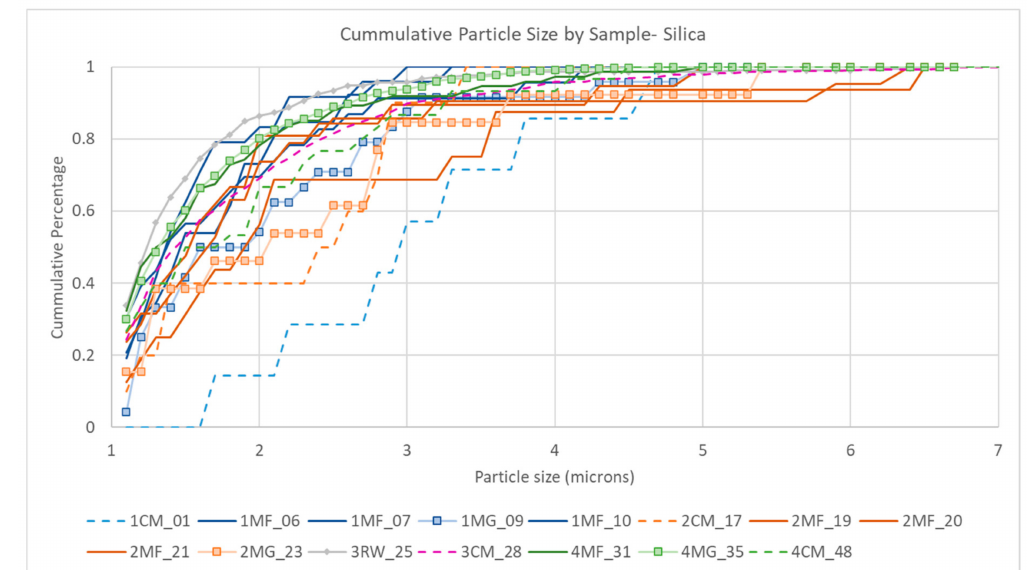
Figure 6. Cumulative particle size for silica particles. X-axis = particle size (microns) and y-axis = cumulative percentage (%).